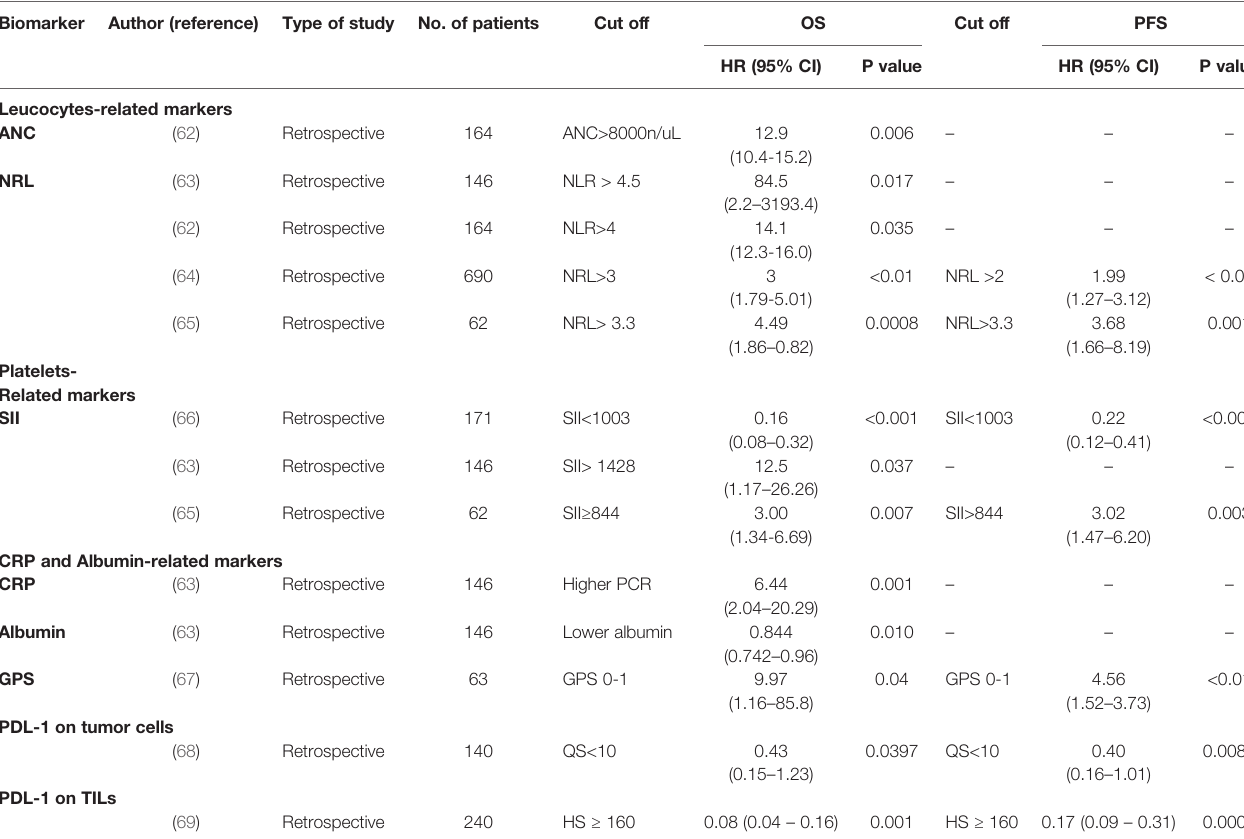
TABLE 1 | Overview of studies investigating the prognostic role of in fl ammatory biomarkers in metastatic testicular cancer. Biomarker Author (reference) Type of study No. of